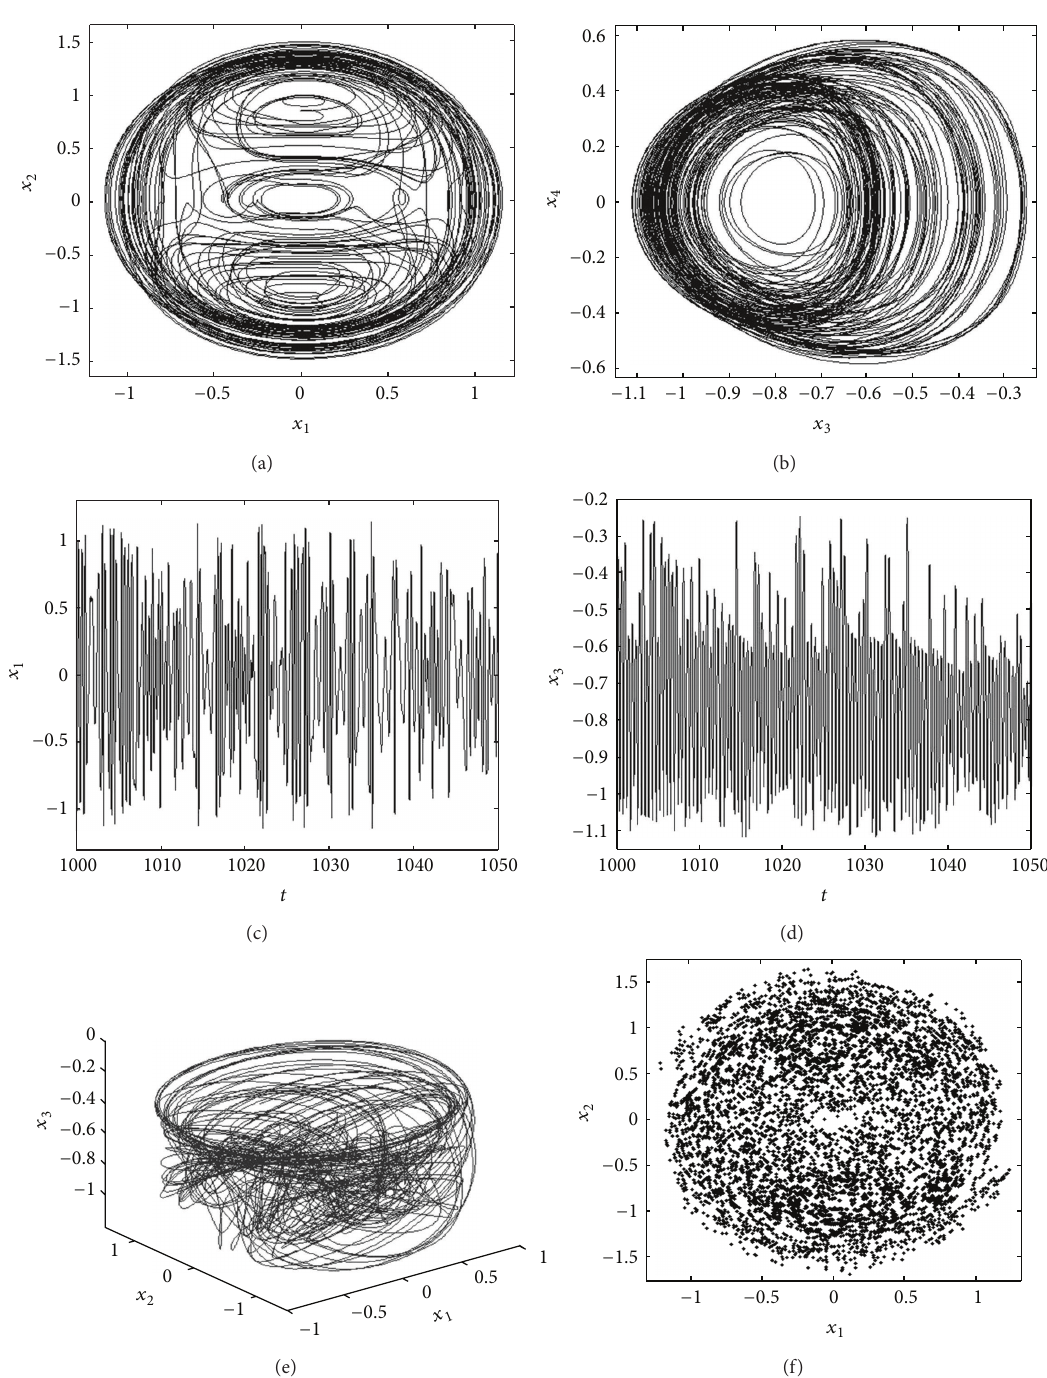
Figure 11: The multipulse chaotic motion is obtained when 𝑓 2 = 55.1 and 𝜇 1 = 0.1 ; (a) the phase portrait on the plane (𝑥 1 ,𝑥 2 ) ; (b) the phase portrait on the plane (𝑥 3 , 𝑥 4 ) ; (c) the waveform on the plane (𝑡,𝑥 1 ) ; (d) the waveform on the plane (𝑡,𝑥 3 ) ; (e) the phase portraits in the three-dimensional space (𝑥 1 , 𝑥 2 , 𝑥 3 ) ; (f) Poincare map on the plane (𝑥 1 ,𝑥 2 ) .